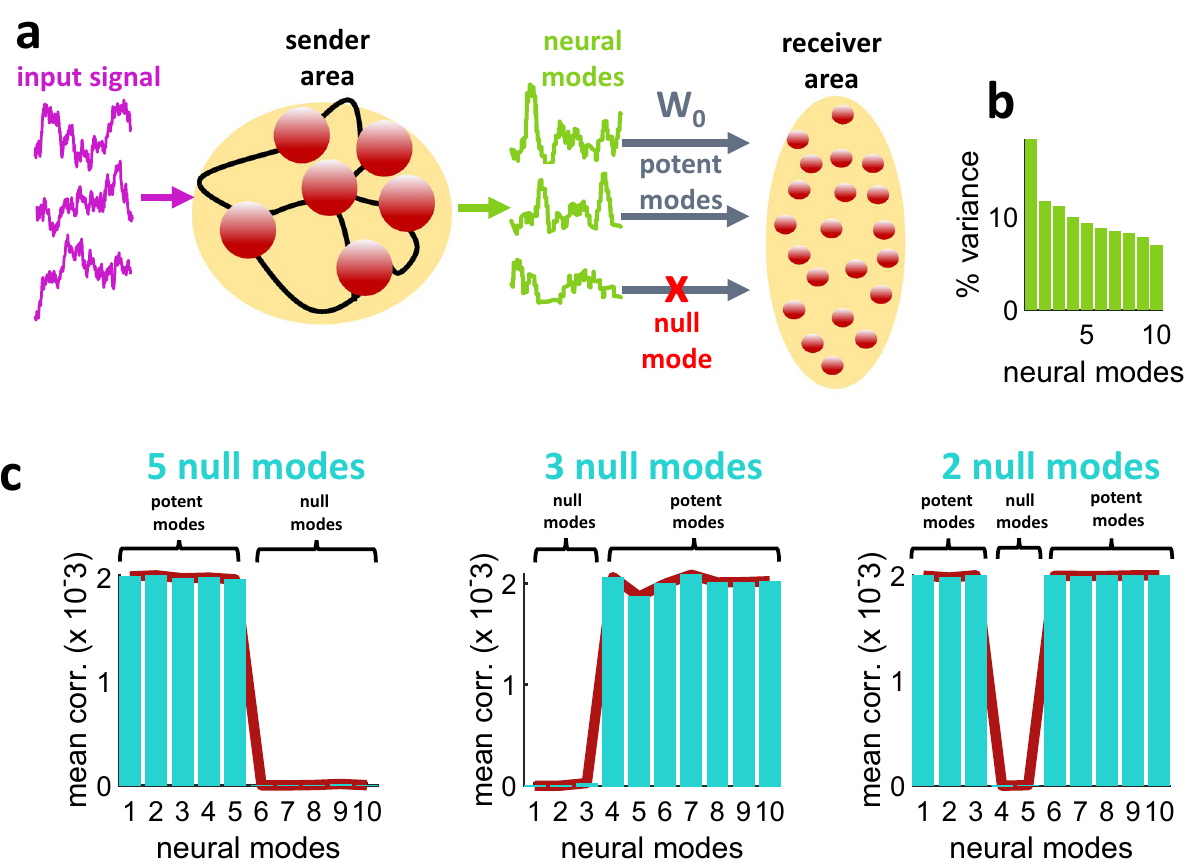
Figure 1. A model of feedforward communication between two neuronal circuits. ( a ) Simplified model where a recurrently-connected sender area receives an input signal and projects to a receiver area via a set of connection weights ( W 0 ) where potent neural modes are transmitted forward while null modes are not. ( b ) Percentage of variance explained by neural modes ( N = 10). ( c ) Across different simulations that altered the number and origin of transmitted neural modes, potent modes yielded a higher correlation between sender and receiver areas than null modes ( N = 10). Results shown were obtained from a receiver area with lateral connectivity (solid lines) and without (vertical